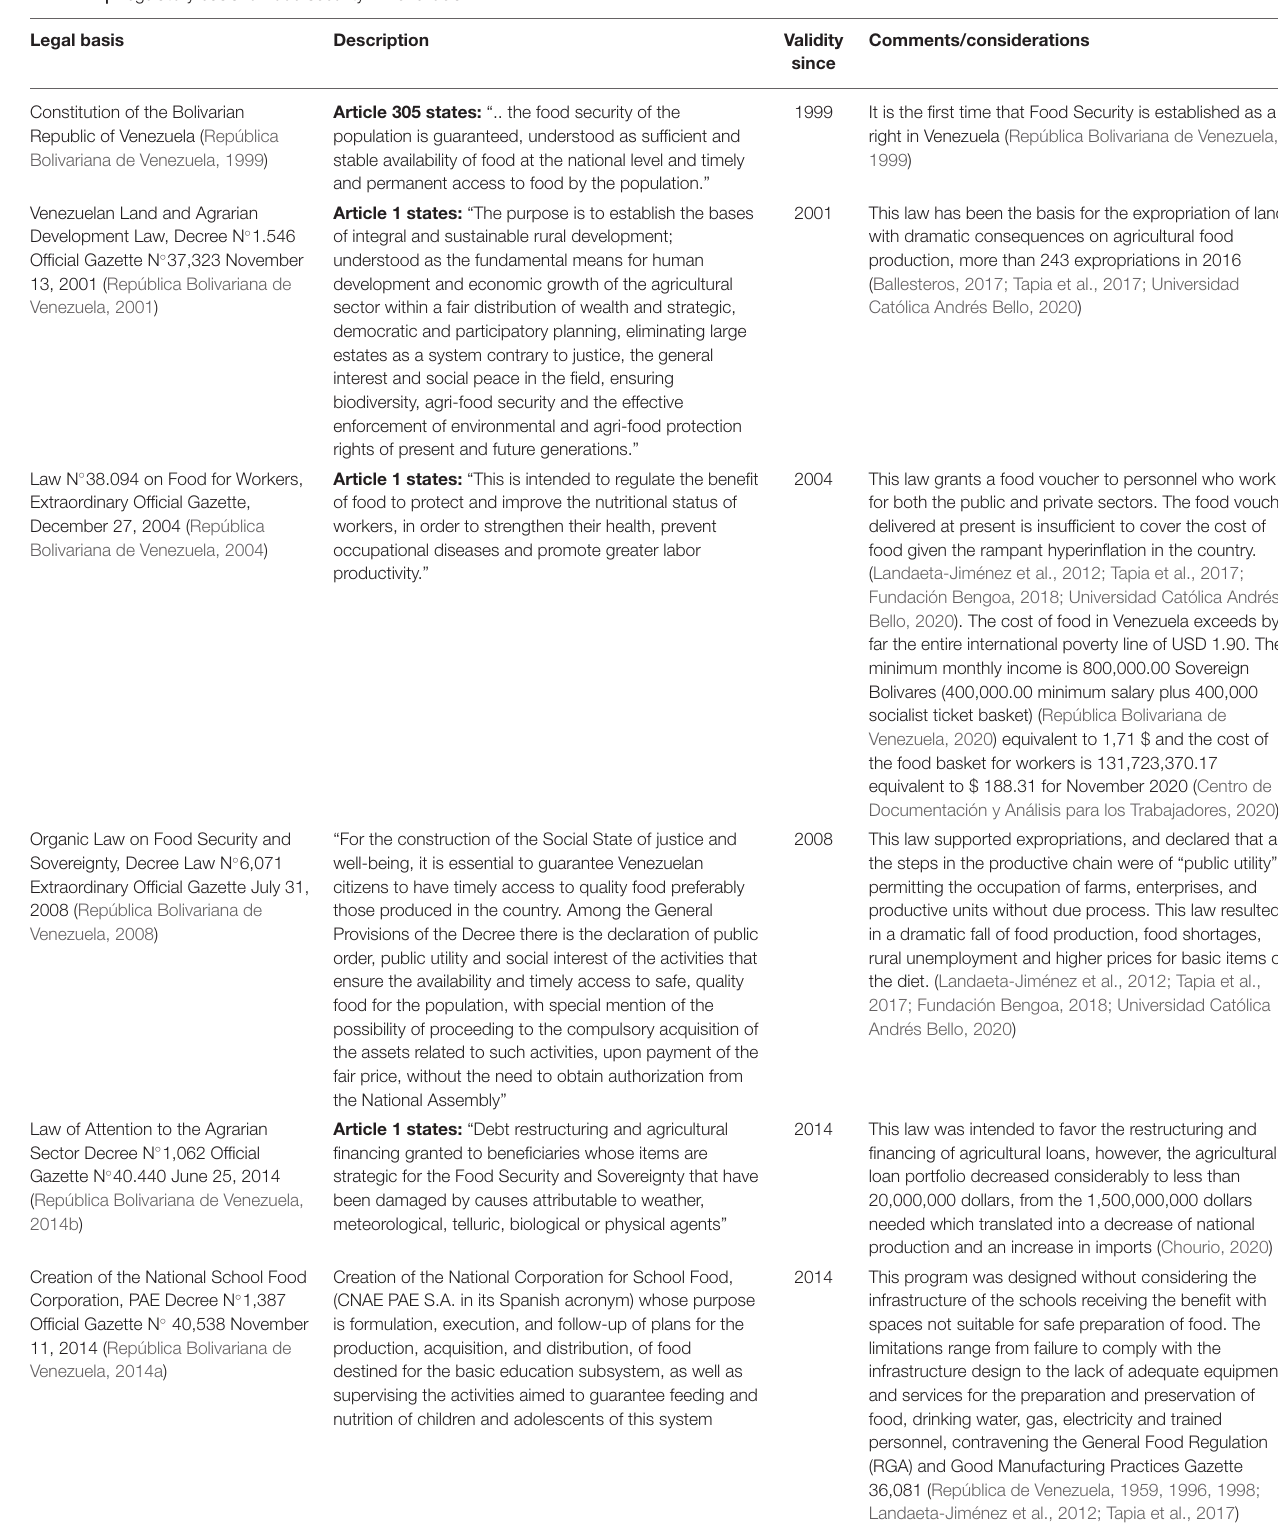
TABLE 1 | Regulatory basis for food security in